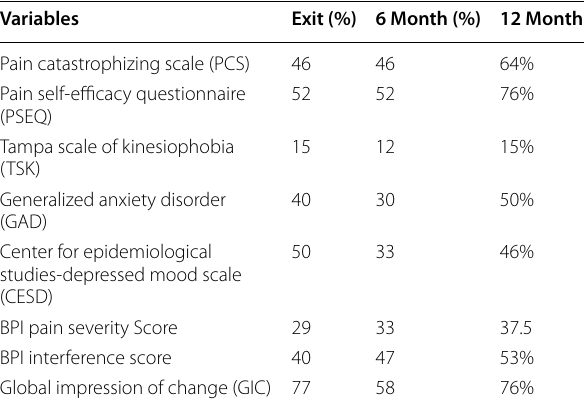
Table 4 Percent of change (improvement) of completers